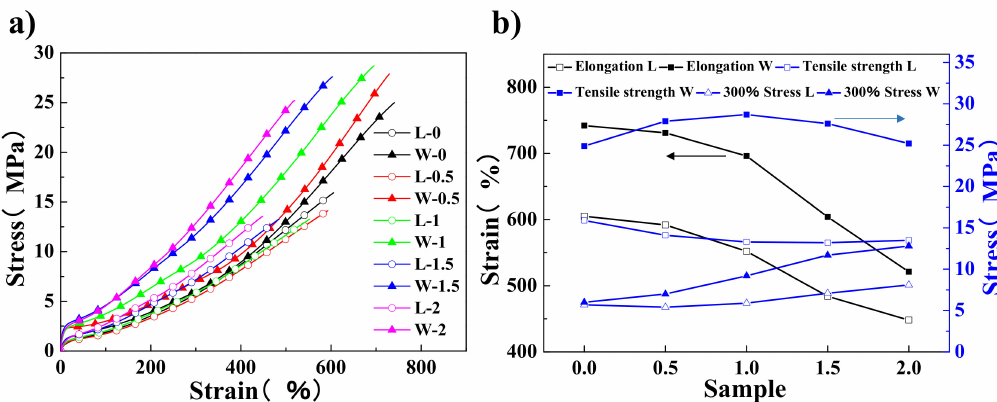
Figure 7. ( a ) The stress–strain curves of the rGO / 60SiO 2 / NR composites with di ff erent rGO contents, prepared by two di ff erent methods. ( b ) The elongation (black line), tensile strength (blue line), and 300% stress (blue line) of di ff erent rGO / 60SiO 2 / NR composites made by the WCL (solid point)